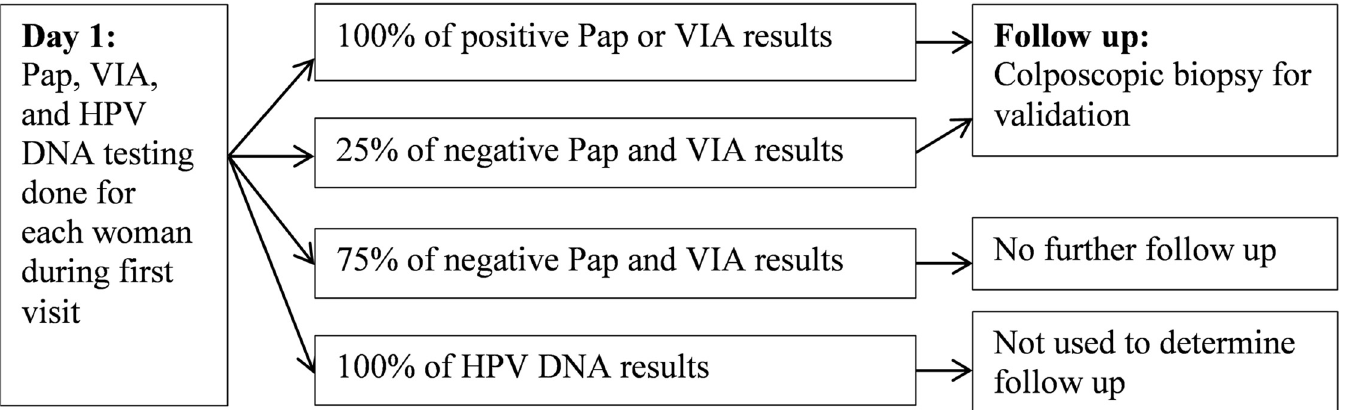
Fig 1. Validation study design for detection of CIN in HIV-positive women. In the validation study, which preceded the study presented here, all women were screened with all methods. After screening and diagnosis all women were followed up using study guidelines and local standards of care.